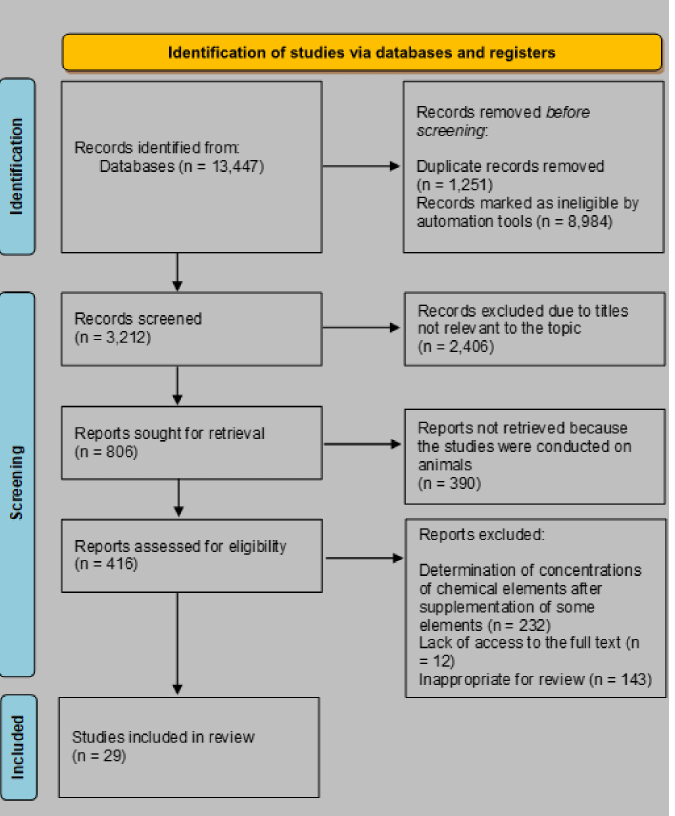
Figure 1. PRISMA (Preferred Reporting Items for Systematic Reviews and Meta Analyses)